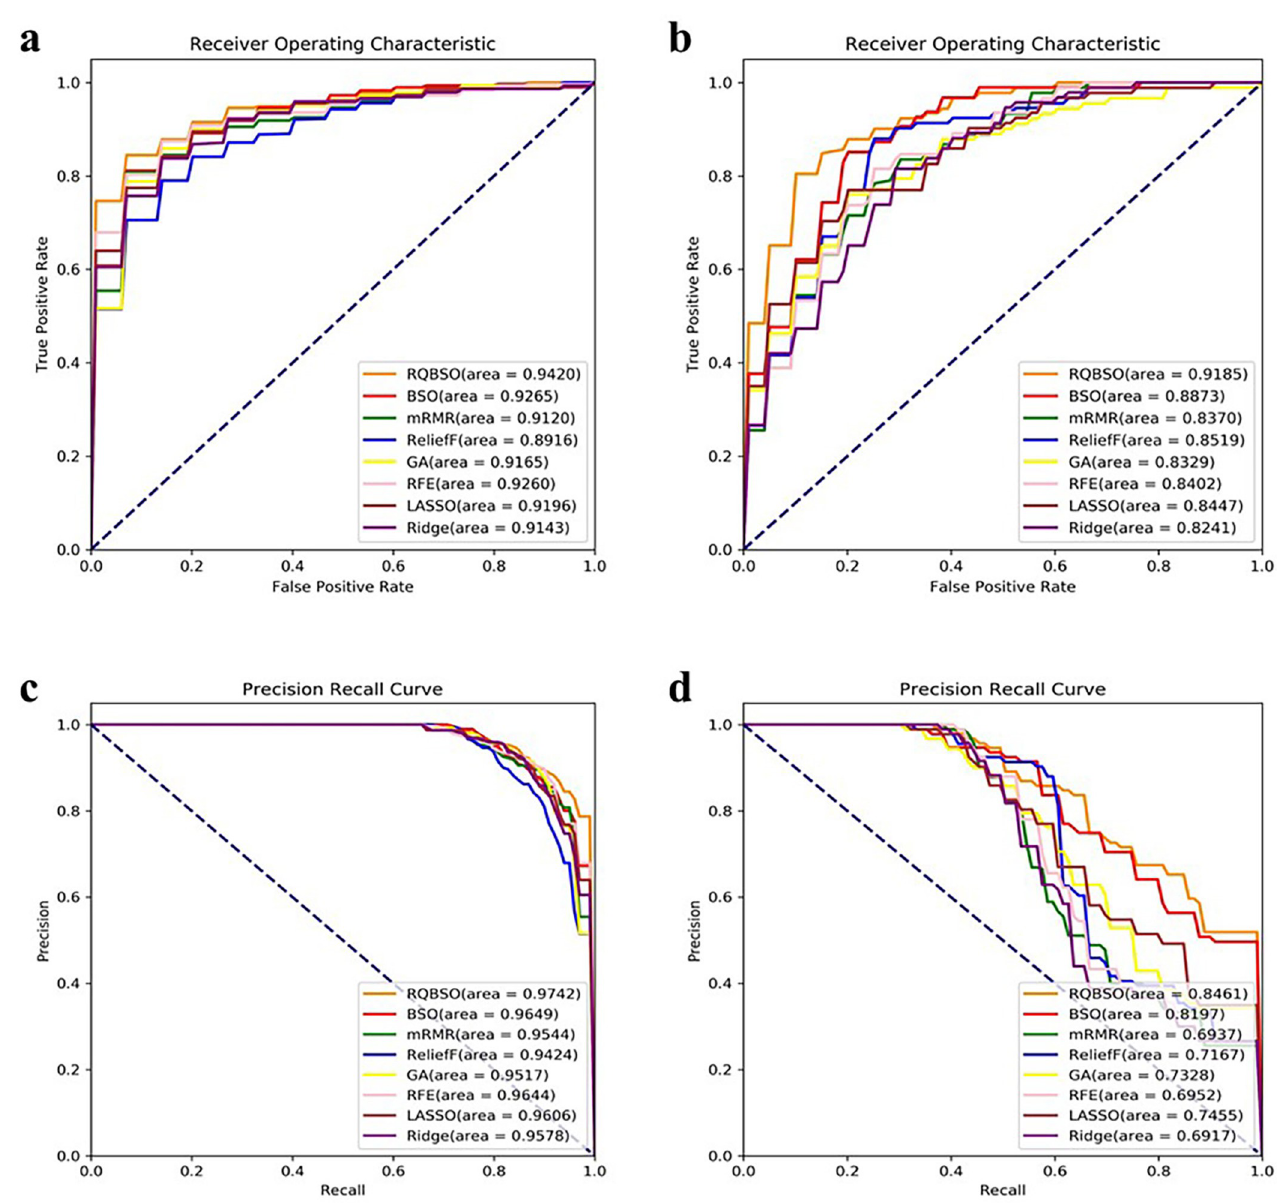
Fig 5. Comparison of ROC and PRC curve of RQBSO and other algorithms. (a, b) correspond to the ROC curve of dataset 1 and dataset 2. The numbers in parentheses indicate the AUROC value. The x-axis represents sensitivity, or true positive rate (TPR). The y-axis is 1-Specificity, or false positive rate (FPR). (c, d) represents the PRC curve of dataset 1 and dataset 2. The numbers in parentheses indicate the AUPRC value. The x-axis represents recall. The y-axis is